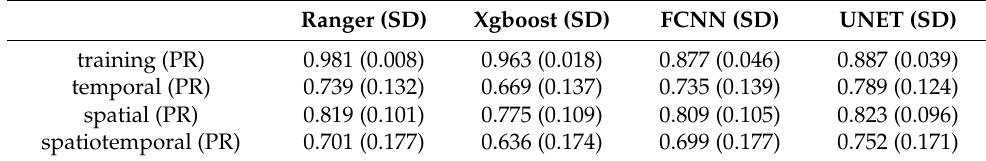
Table 6. Summary Spatiotemporal Generalization—Precision.